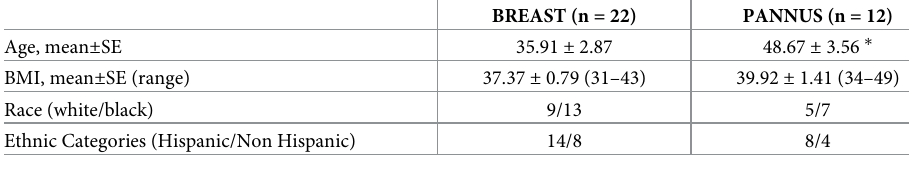
Table 1. Demographic characteristics of enrolled